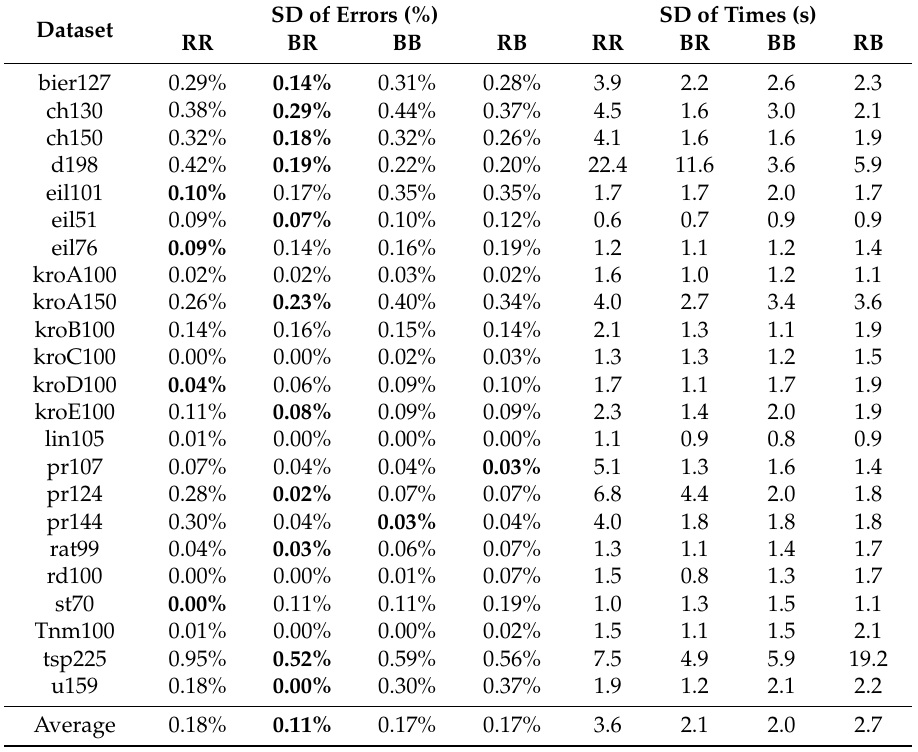
Table 2. Standard deviations of errors and times obtained for the analyzed TSP datasets solved with di ff erent sets of